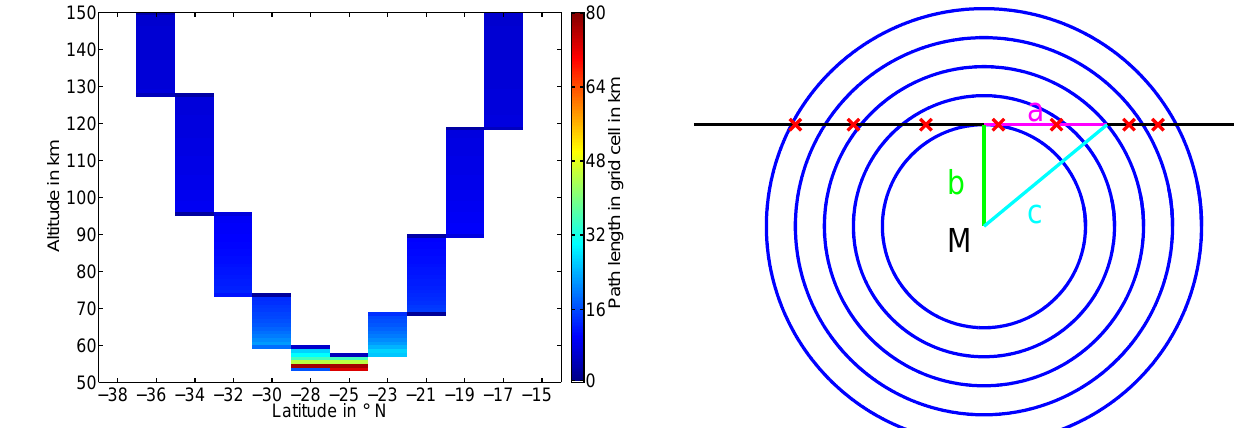
Fig. 15. 2-D intersection of Earth’s atmosphere, with the center of Earth, M, and the altitudes as radii of the circles. Path lengths along the line-of-sight for the vertical grid can be found with right-angled triangle algebra. Changes of the latitude in a vertical grid cell are added as additional sides a (red crosses). The path length in each grid cell is the difference of the sides a of neighboring grid cells. Note that, depending on the binning of the latitudes, it is possible that all grid cells only have one